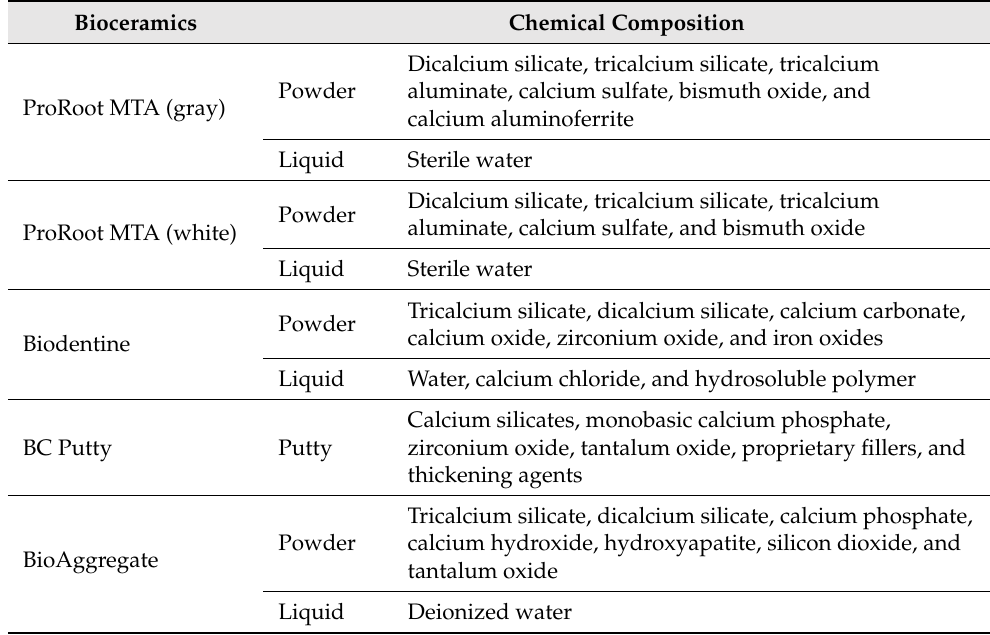
Table 1. Composition of bioceramic products used in